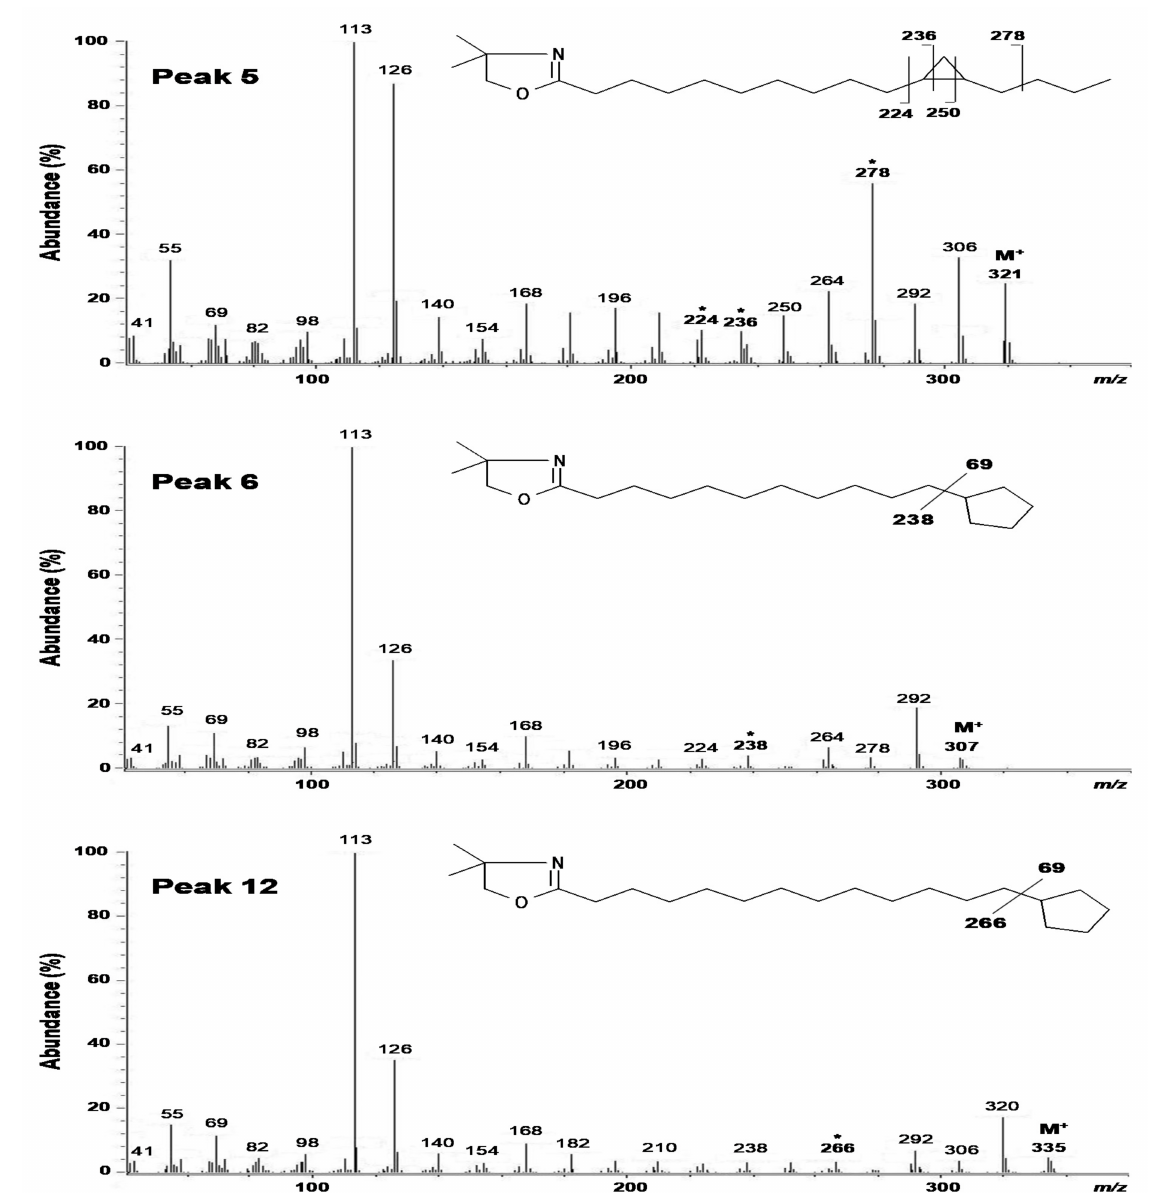
Figure 3. GC-MS profiles of the DMOX derivatives of the saturated fraction of total fatty acids from Solieria pacifica . TIC, total ion current chromatogram. For peak identification, see Figure